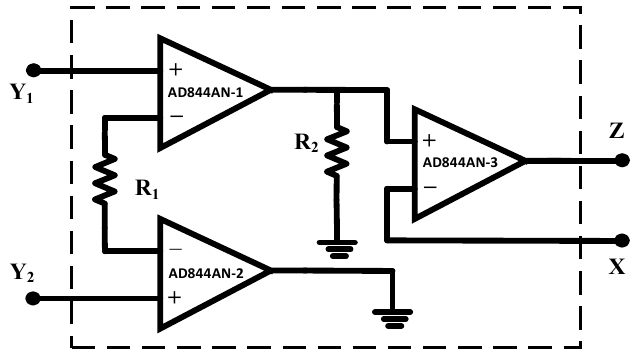
Figure 17. DVCC implementation using AD844AN.